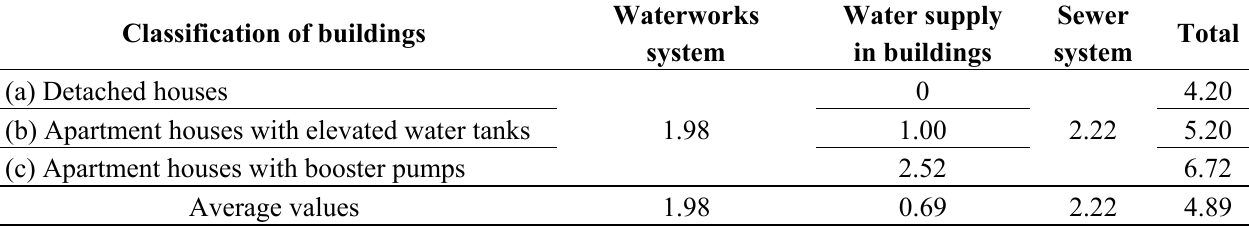
Table 2. Energy consumption rates of Japanese water system for housing (MJ/m 3